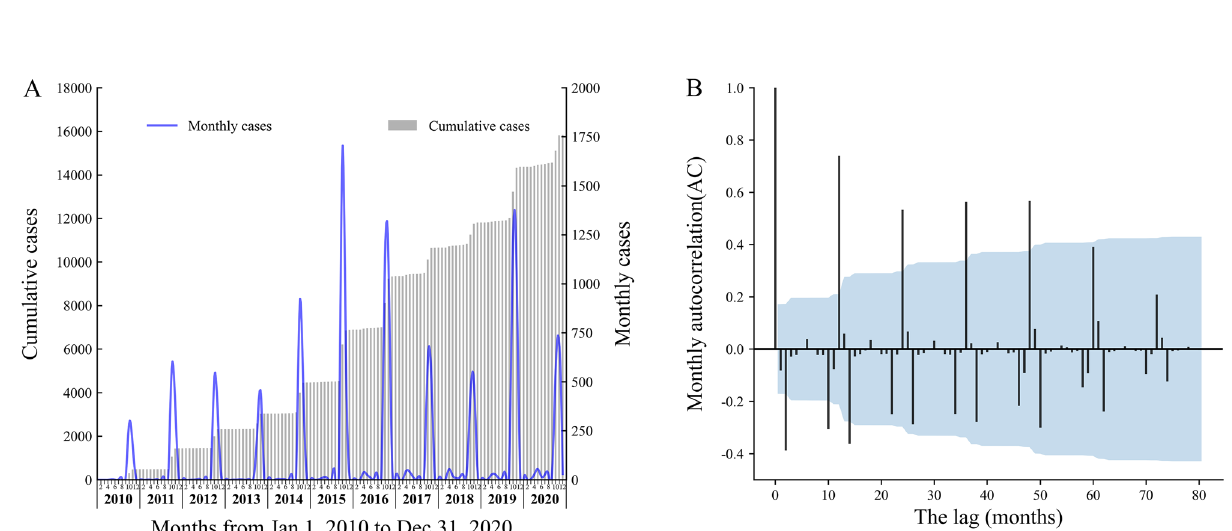
Figure 2. Temporal distribution and Seasonal patterns in reported scrub typhus cases from 2010 to 2020 in Anhui, China. The temporal distributions of reported scrub typhus cases in Anhui are presented as monthly number of cases (blue line) and cumulative cases (grey spikes) in panel A and the seasonal patterns as determined by monthly autocorrelation between the number of reported cases for each month is presented using time lags between 0 and 80 months in panel